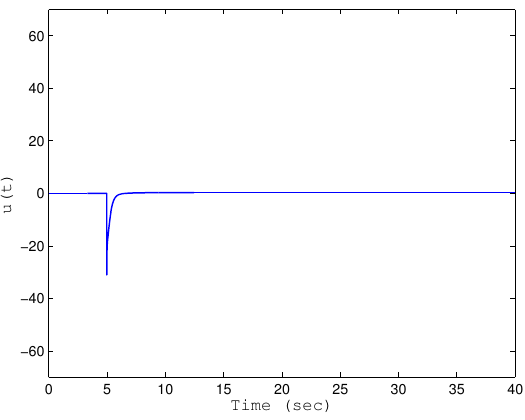
Figure 4. The time response of the controller u ( t ) .